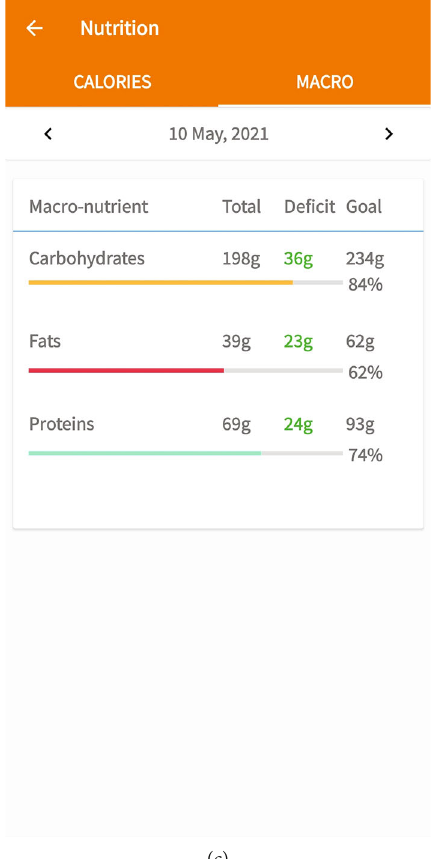
Figure 9: User interface report showing (a) user diary of meal activities, (b) calorie consumption, and (c) macronutrient consumption.